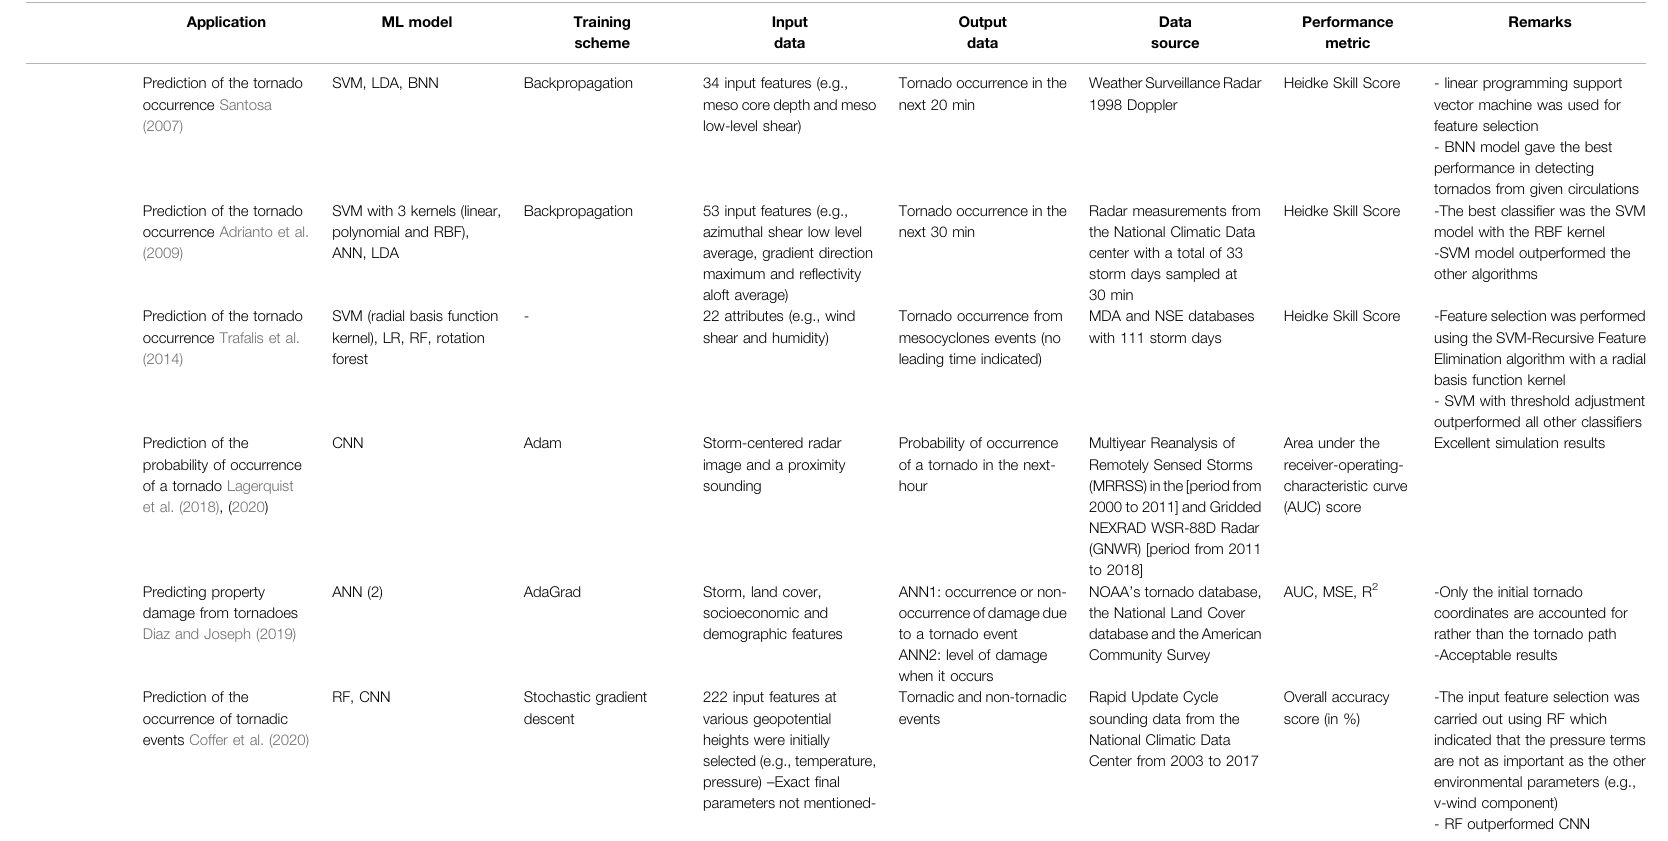
TABLE 3 | ( Continued ) Summary of ML applications for non-synoptic